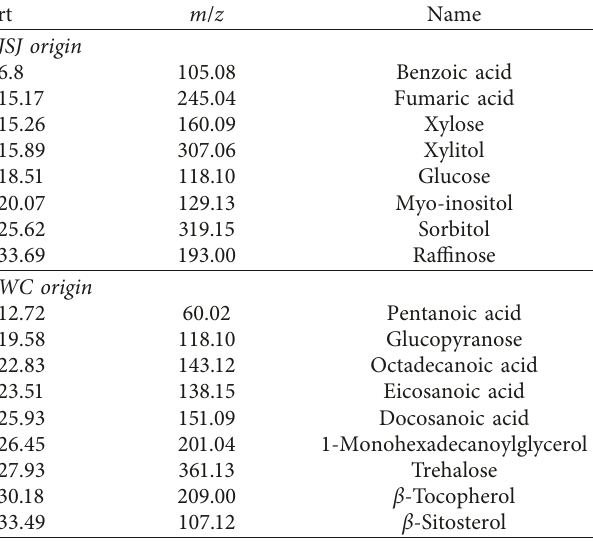
Table 1: Special metabolites of rice in two